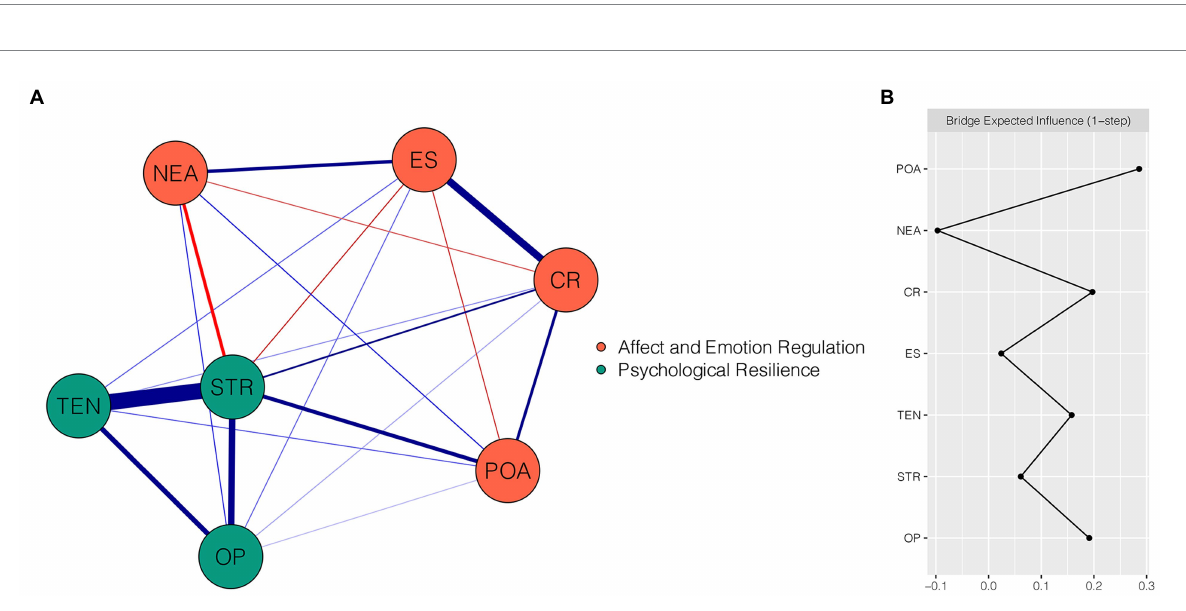
FIGURE 2 Network structure of emotion regulation, affect, and psychological resilience dimensions. (A) EBICglasso network, where blue edges represent positive correlations and red edges represent negative correlations. A thicker edge reflects a higher correlation between nodes. (B) Centrality plot depicting the bridge expected influence of each node in the network (raw value). CR, cognitive reappraisal; ES, expressive suppression; POA, positive affect; NEA, negative affect; TEN, tenacity; STR, strength; OP,